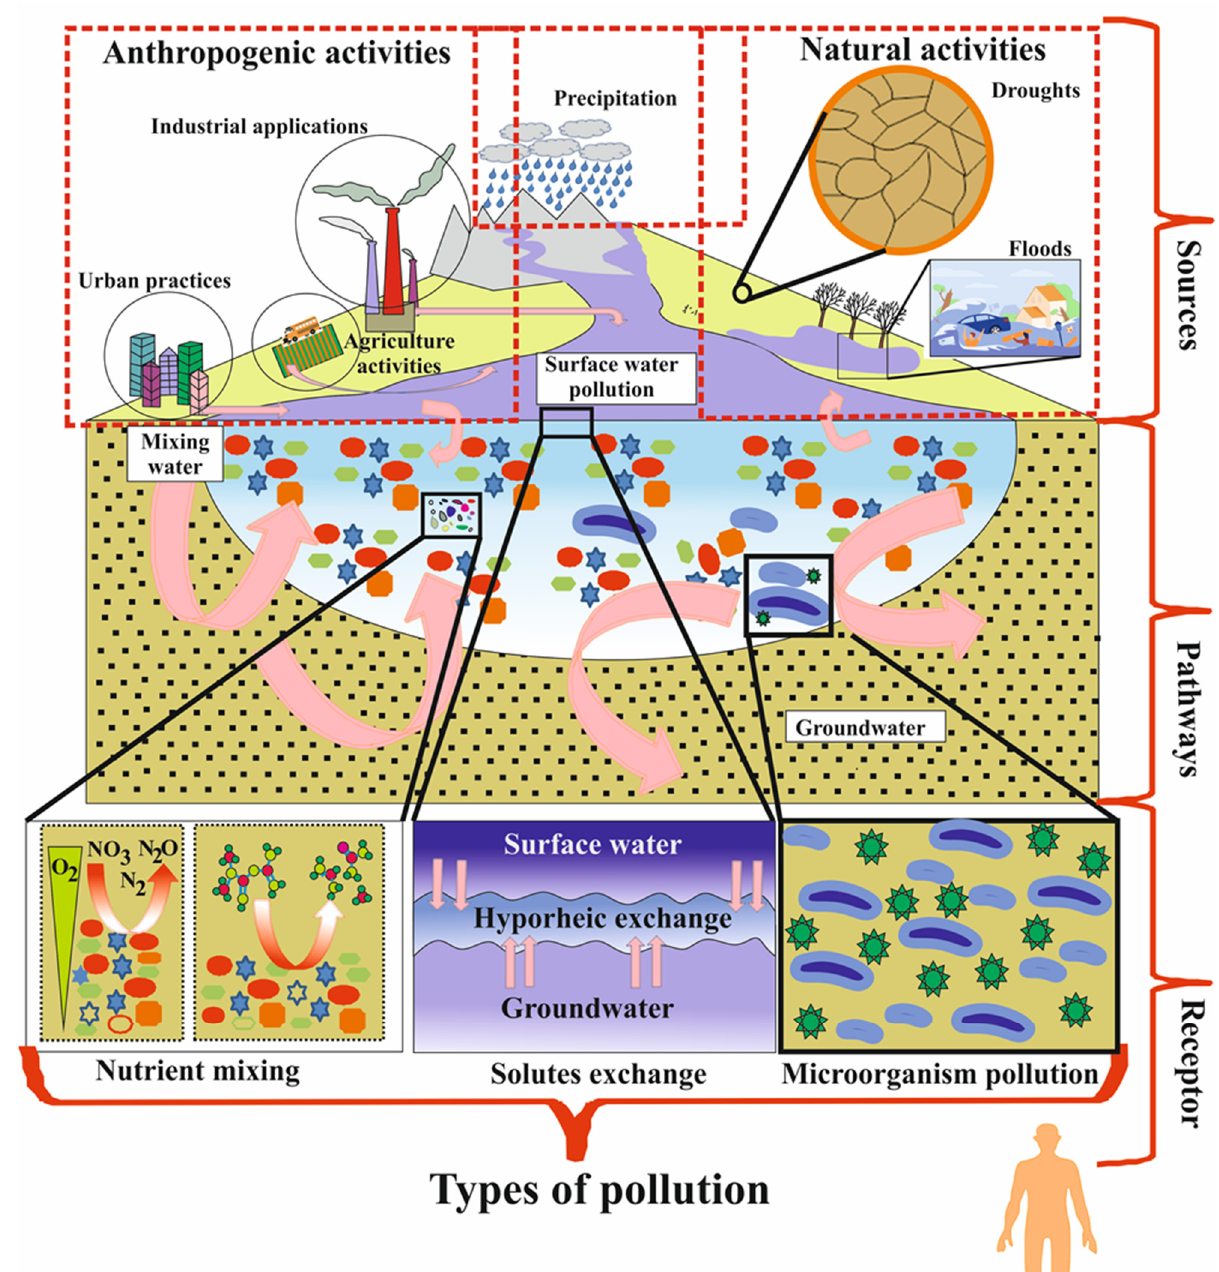
Figure 1. Schematic diagram illustrates water contamination due to natural sources (droughts and floods) and anthropogenic sources (industrial, agriculture, and urban activities), their pathways, receptors, and other types of pollution.